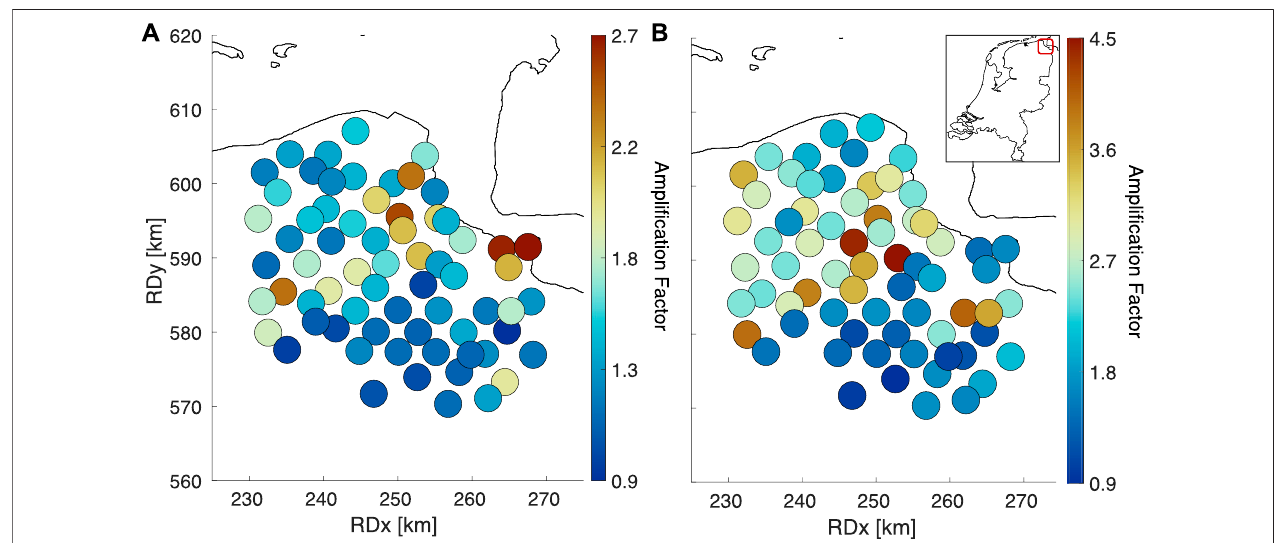
FIGURE 6 | (A) Spatial distribution of the ampli fi cation factors computed based on earthquake records on the vertical component of the borehole seismometer at 200 m and at the surface. (B) Spatial distribution of the ampli fi cation factors computed based on earthquake records on the horizontal components of the borehole seismometer at 200 m and at the surface, modi fi ed from van Ginkel et al. (2019).